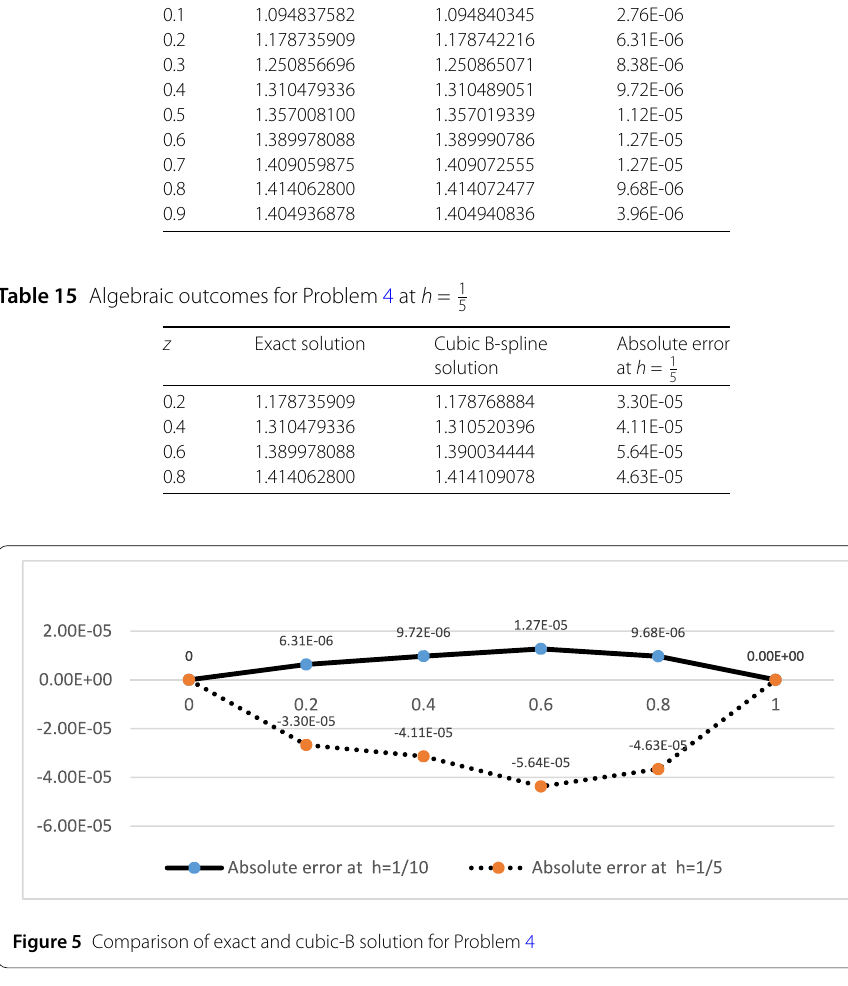
Table 14 Algebraic outcomes for Problem 4 at h = 1